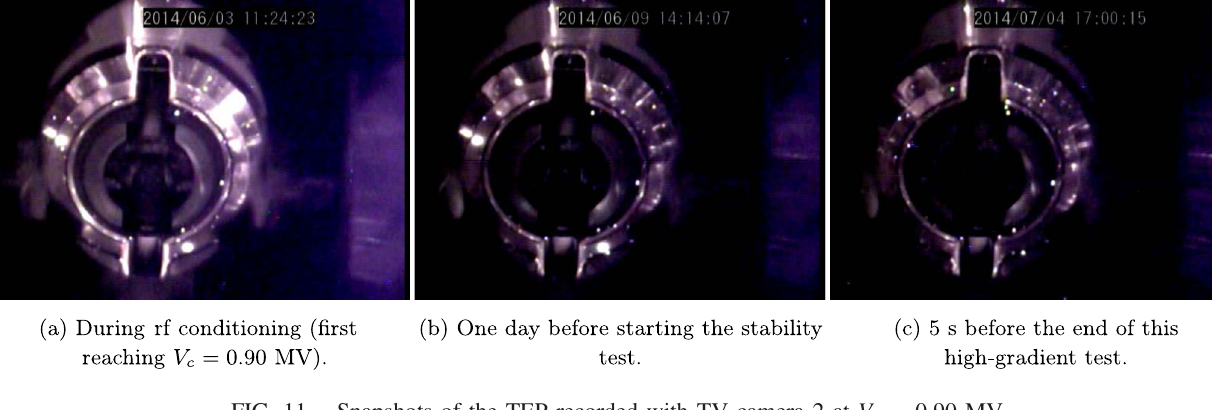
FIG. 11. Snapshots of the TEP recorded with TV camera 2 at V c ¼ 0 . 90